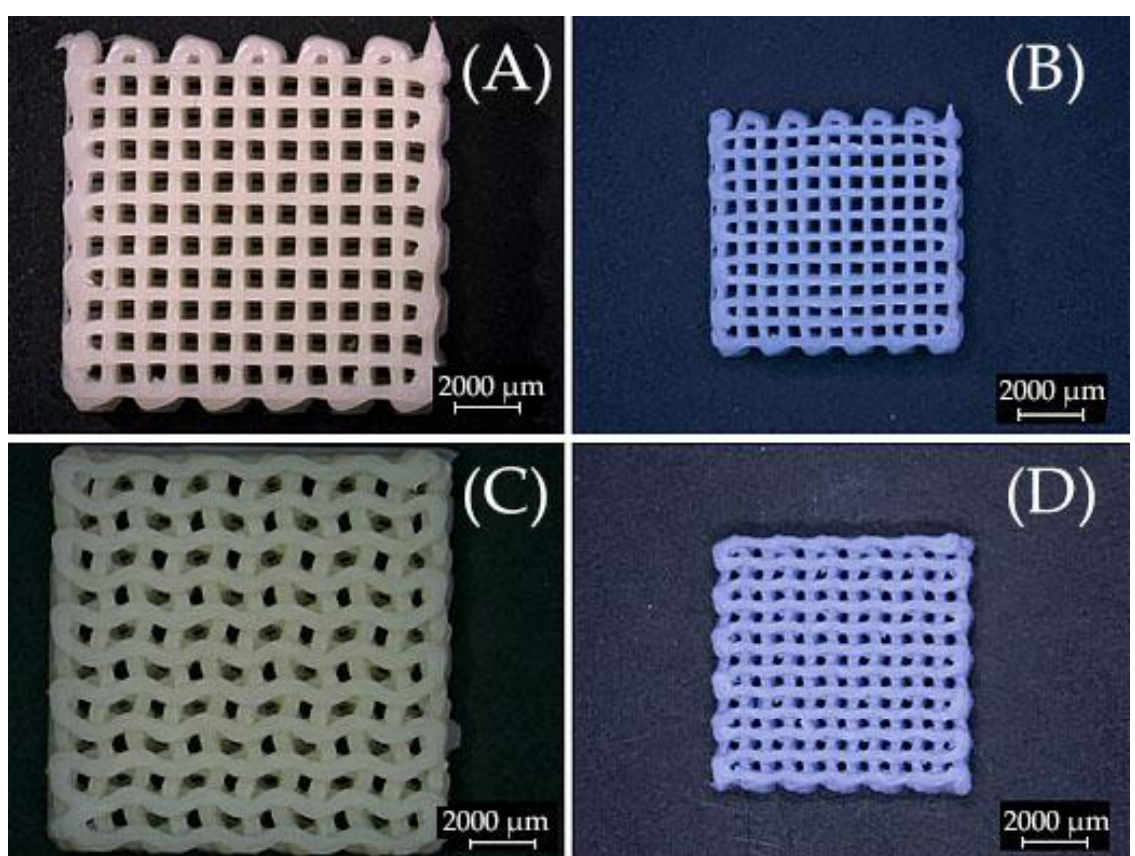
Figure 10. Optical microscopy images of 3D printed scaffolds ( A ) rectilinear as printed; and ( B ) sin- tered at 1300 °C; ( C ) gyroid as printed; and ( D ) sintered at 1300 °C.